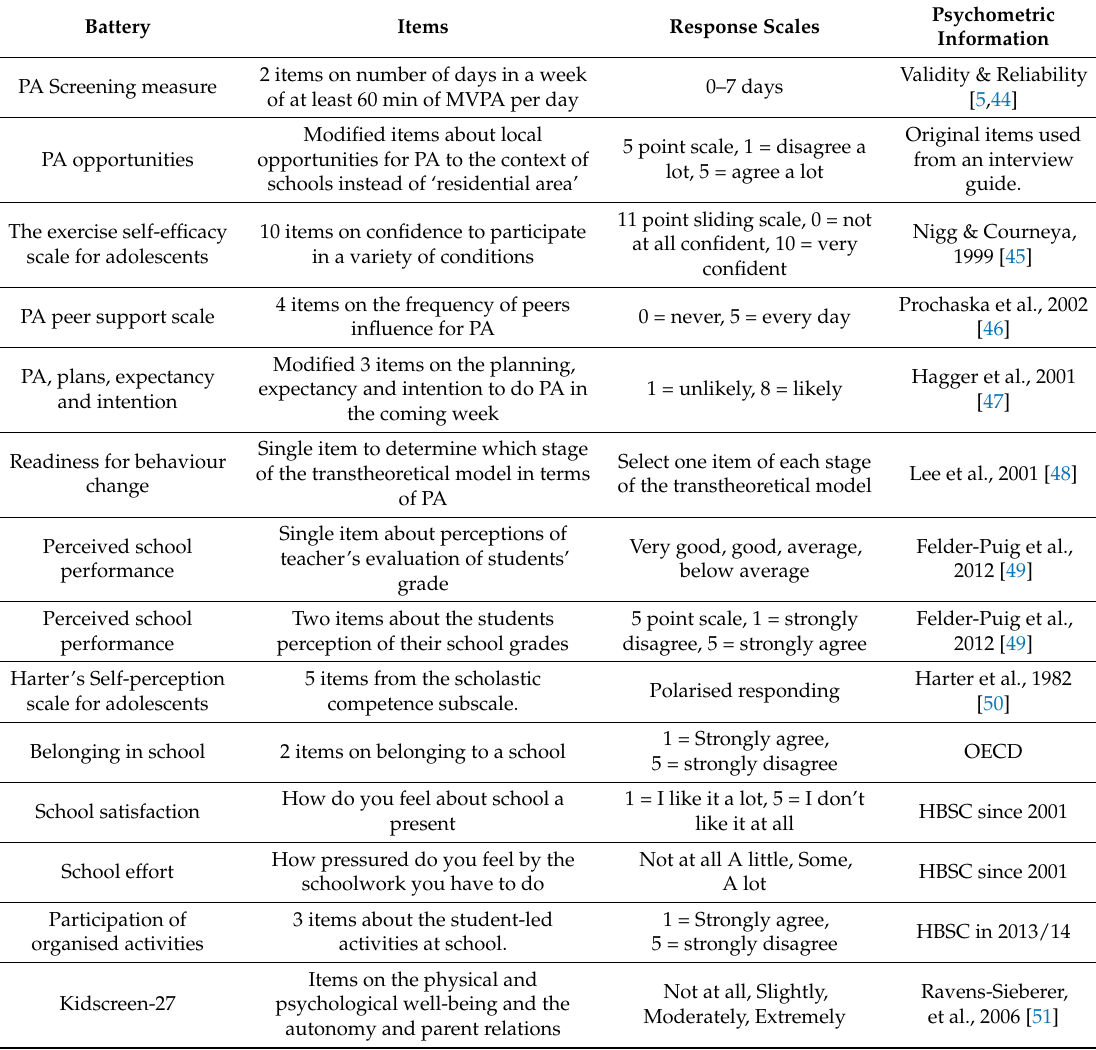
Table 3. Battery of